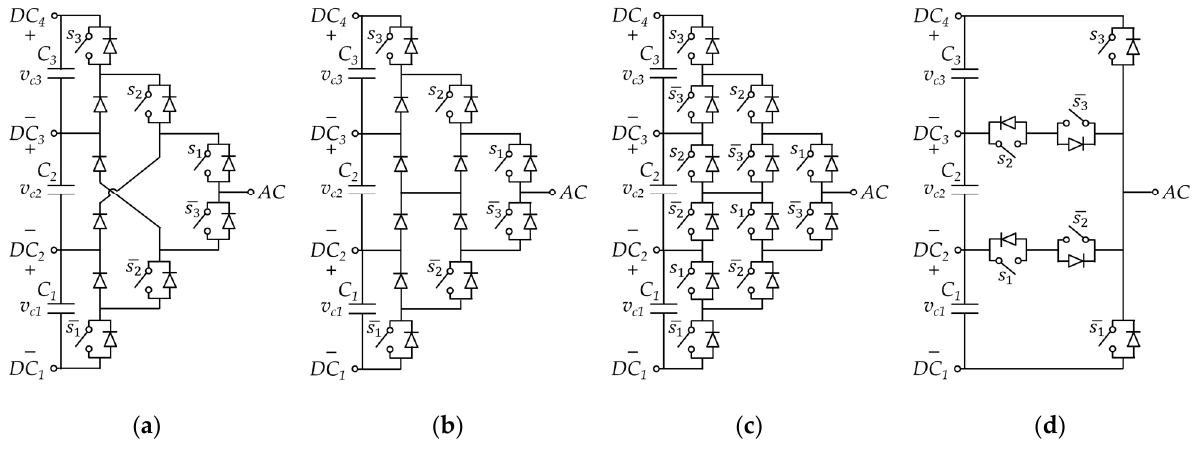
Figure 2. Main leg topologies of NPC converters, for four levels: ( a ) diode-clamped; ( b ) modified diode-clamped; ( c ) active-clamped; ( d ) reduced active-clamped.